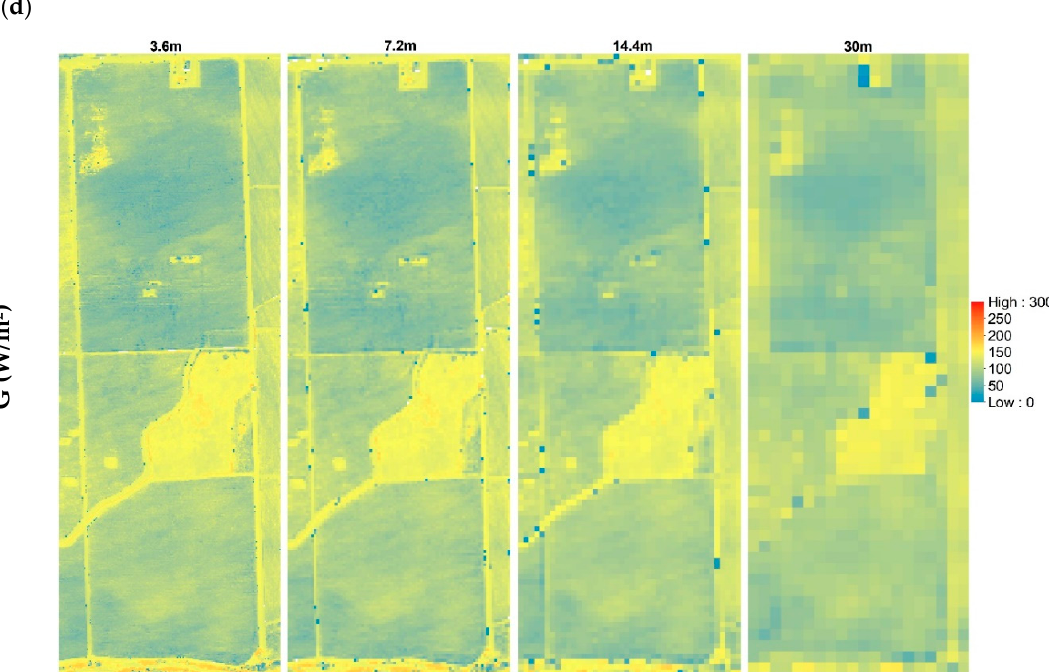
Figure A4. Aggregation of surface energy fluxes across di ff erent spatial domain (3.6 m, 7.2 m, 14.4 m, and 30 m) on August 09, 2014: ( a ) R n , ( b ) LE , ( c ) H , and ( d ) G .